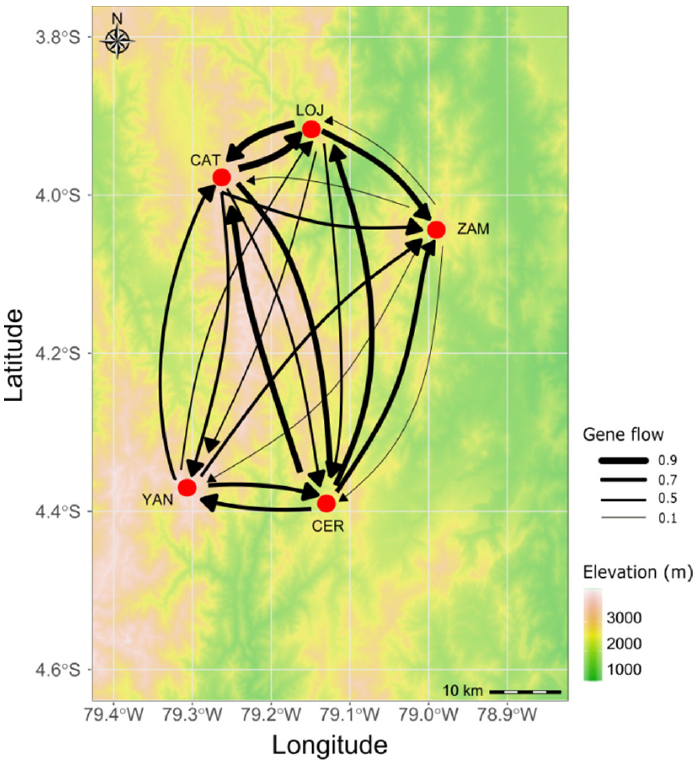
Figure 2. Diagram of the relative magnitude and direction of gene flow between O. rotundata populations. Arrows thickness shows normalized Nm values and arrowheads the estimated direction of gene flow. Results were plotted against the topographic map of populations showing only elevation. Population labels refer to Table 2.